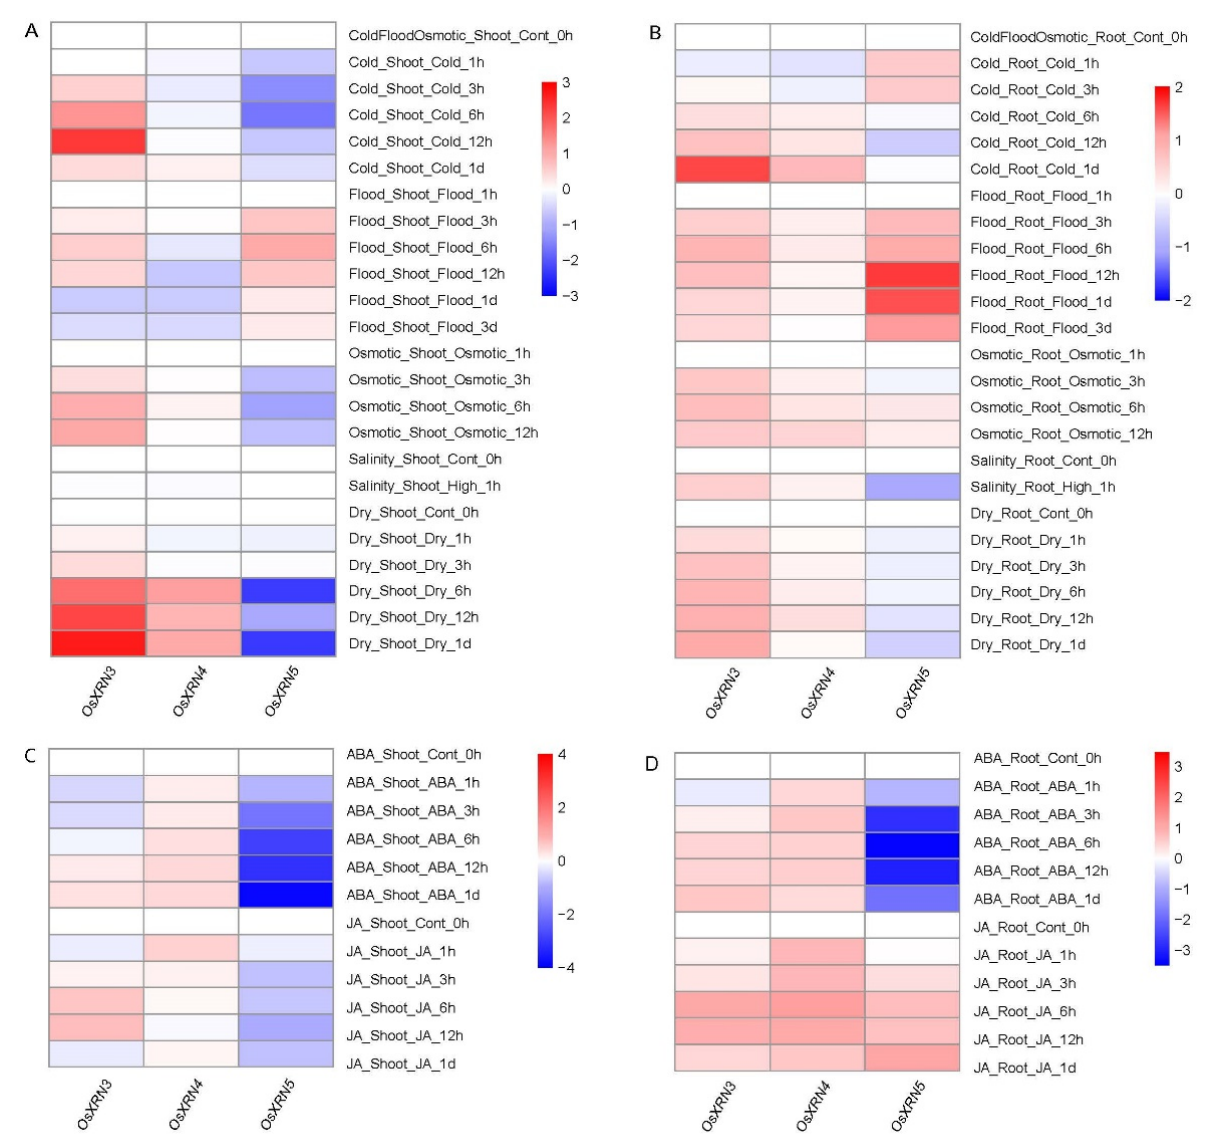
Figure 5. Cluster analysis of the OsXRNs expression pattern. ( A , B ) Heatmap showing expression profiles of OsXRNs in response to diverse abiotic stress in rice shoot ( A ) and root ( B ). ( C , D ) Heatmap showing expression profiles of OsXRNs in response to phytohormones in rice shoot ( C ) and root ( D ). The expression level is represented using color scale ranging from blue (down-regulated) to red (up-regulated).